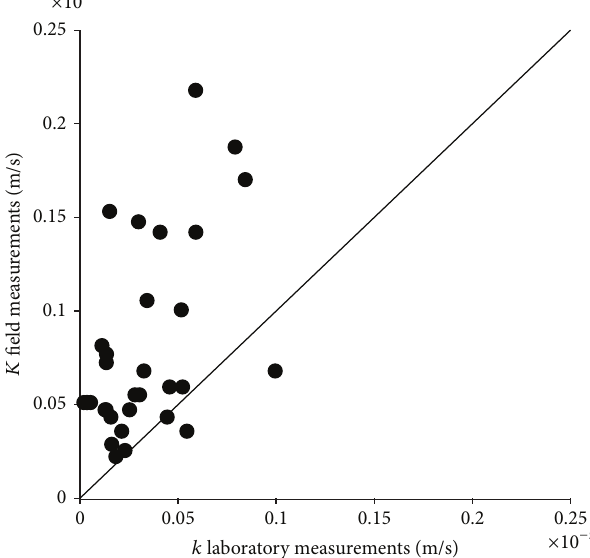
Figure 8: Comparison between hydraulic conductivity values measured for each soil sample in laboratory and in field for the correspondent 𝑛 𝑒